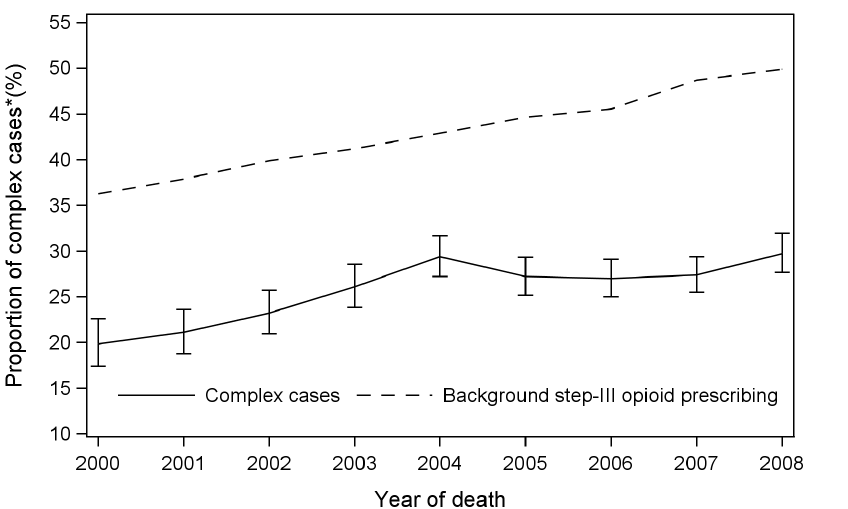
Figure 1. Percentage (95% CI) of patients receiving more than one types of strong opioids in the last three months of life, England 2000–2008 (N=13, 427). *A complex case refers to a patient being prescribed for more than one type of strong opioids in the last three months of life.